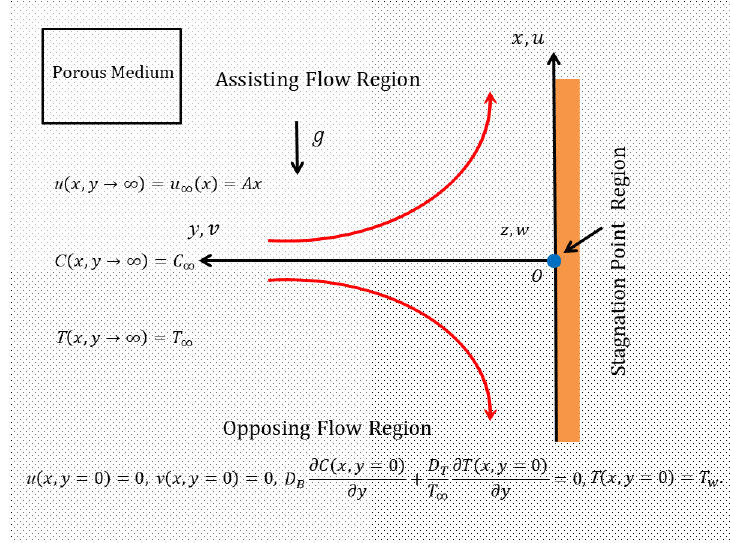
Figure 1. Physical model of the problem.